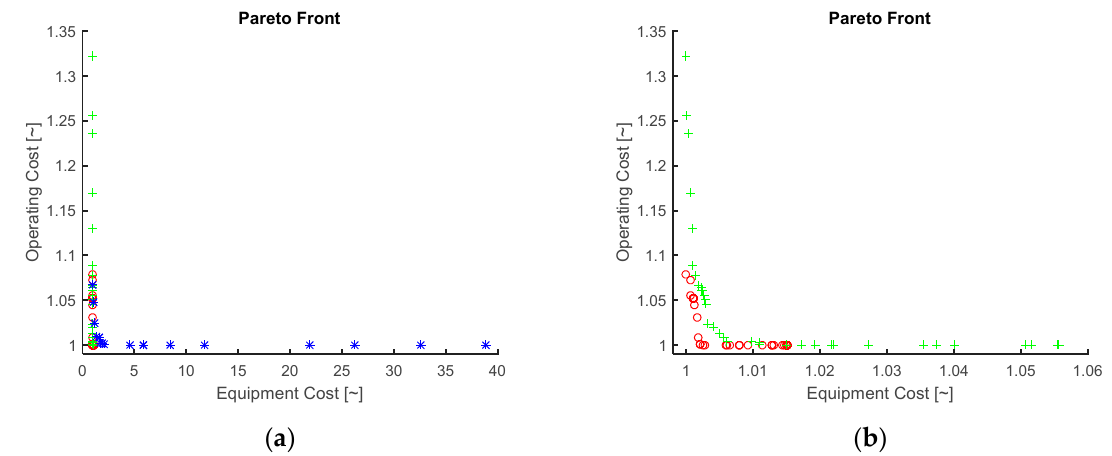
Figure 5. Pareto optimal solutions for the simultaneous minimization of equipment and annualized cost of ( a ) all three alternative configurations and ( b ) the IMR and CRM configurations. IMR configuration (red circle), CRM (green plus) and CRMRM (blue asterisk).